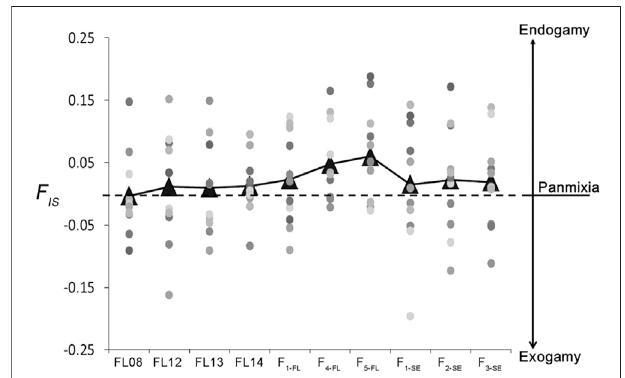
FIGURE 3 | The inbreeding coef fi cient ( F IS ) of lined seahorse collections (4 wild collections, 3 hatchery strains and 3 “ stock enhancement ” strains). Dots with different colors represent different microsatellite loci. Triangles represent the mean values of F IS of different